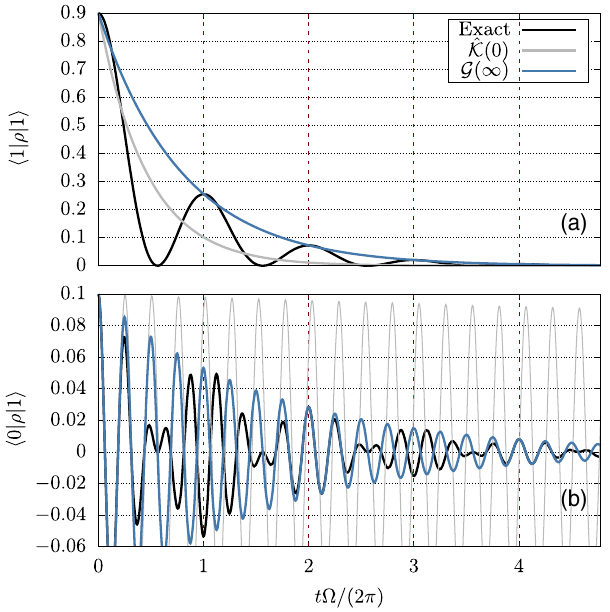
FIG. 3. Jaynes-Cummings model, underdamped regime Γ = γ ¼ 13 ( Ω = γ ¼ 5 ) and ε ¼ 20 . (a) Decay of the excited state occupation h 1 j ρ ð t Þj 1 i and (b) decay of the real part of the coherence h 0 j ρ ð t Þj 1 i . The initial state is ρ ð 0 Þ ¼ 0 . 1 ½j 00 Þ þ j 01 Þ þ j 10 Þ(cid:2) þ 0 . 9 j 11 Þ . Shown are the solution for the Markovian approximations _ ρ ð t Þ ≈ − i G ð ∞ Þ ρ ð t Þ (blue line) with generator obtained by iteration of the stationary fixed point equation (15), ˆ K and _ ρ ð t Þ ≈ − i ð 0 Þ ρ ð t Þ (gray line). The exact solution is shown in